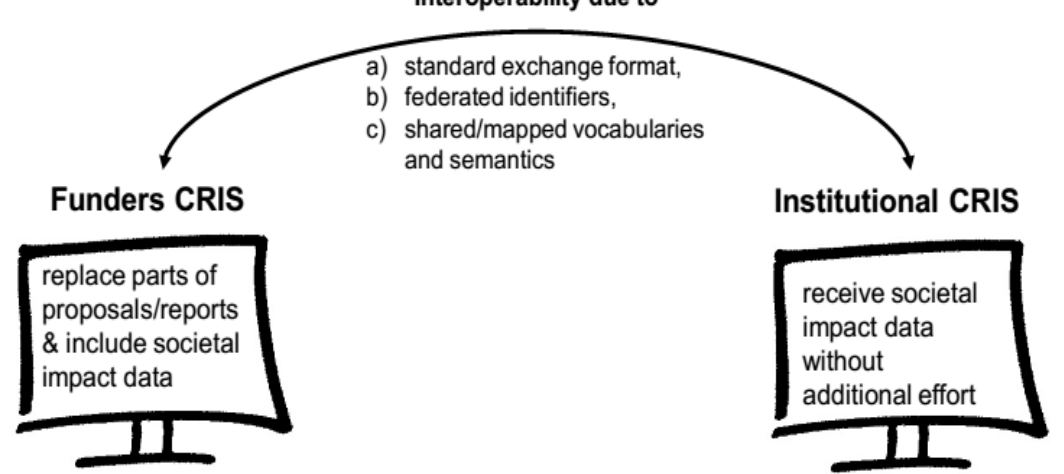
Figure 2. Possibilities for using and developing Current Research Information Systems (CRIS) for inter- operable data transfer between funders and institutions to assess and use societal impact data without additional